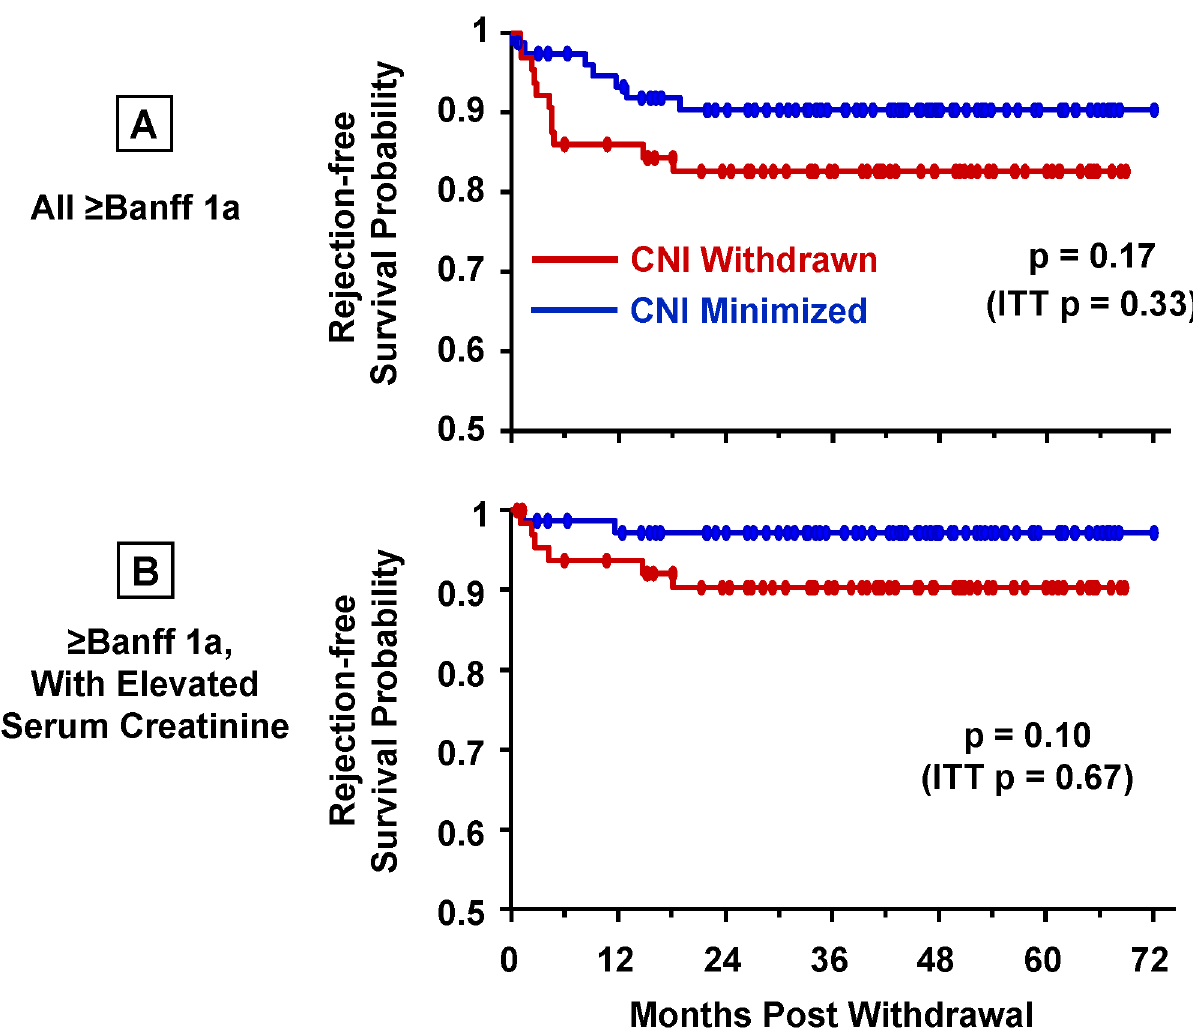
Fig 7. Rejection after CNI withdrawal. On-treatment Kaplan-Meier analyses and log-rank tests (CNI minimized, n = 77; withdrawn, n = 64); intent-to-treat (ITT) p-values are included in the figures. (A) All biopsy findings of rejection (cid:3) Grade 1A. The majority of rejection episodes after six months were low-grade Banff 1A: CNI minimized, 73% (4/7); CNI withdrawn, 70% (7/10). The number of higher-grade rejection episodes was similar between the two groups: CNI minimized, 27% (3-IB); CNI withdrawn, 30% (2-IB, 1-IIA). (B) Rejection (cid:3) Grade 1A accompanied by clinically elevated serum creatinine ( > 30% above baseline). Only 18% of all rejection events in the CNI-minimized group were associated with an increase in serum creatinine. In contrast, 60% of rejection events in the CNI-withdrawn group associated with elevated serum creatinine (p =